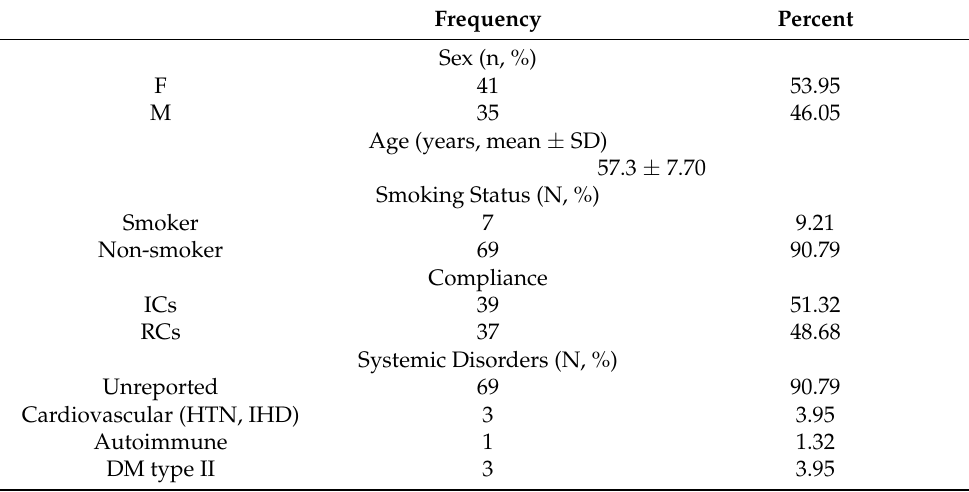
Table 1. Patients’ characteristics and